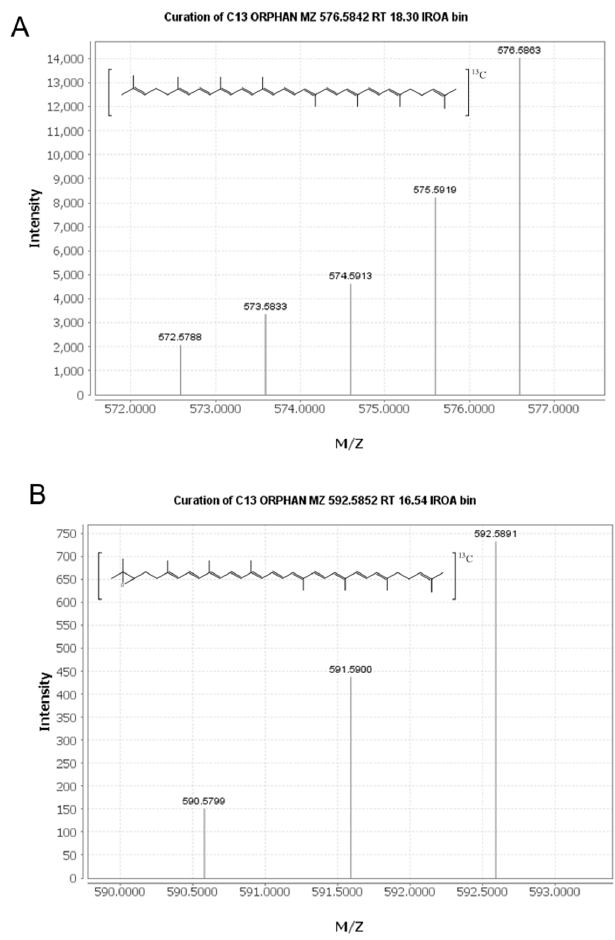
Figure 1. Mass spectra of the 13 C-labeled lycopene ( A ) and lycopene epoxide ( B ) detected with the IROA ClusterFinder software.